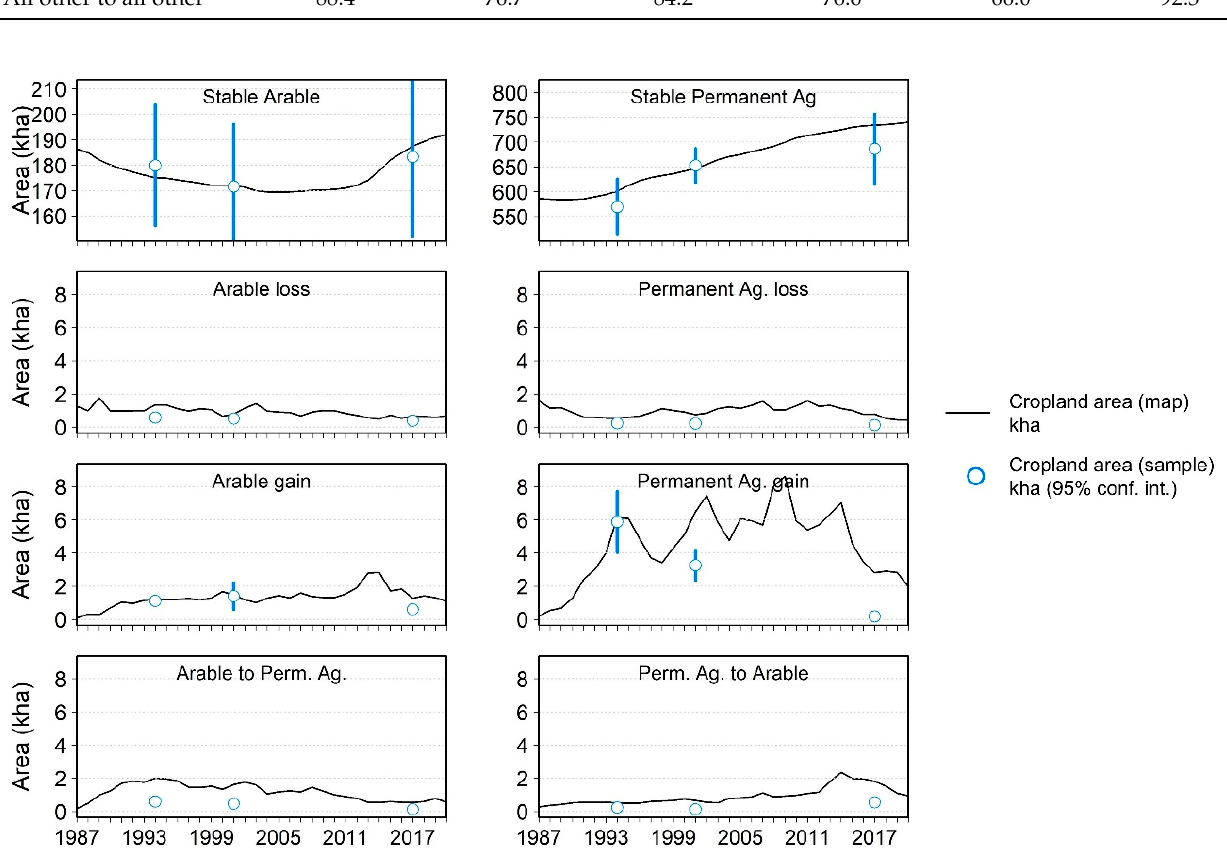
Figure 9. Map-based and sample-based area estimates for stable and change cropland classes (arable and permanent agriculture). Sample-based analysis was conducted for three time periods (1993–1994, 2000–2001, 2016–2017). Error bars for the area estimates represent 95% confidence intervals. The years on the x -axis represent the last year in each bi-annual period.